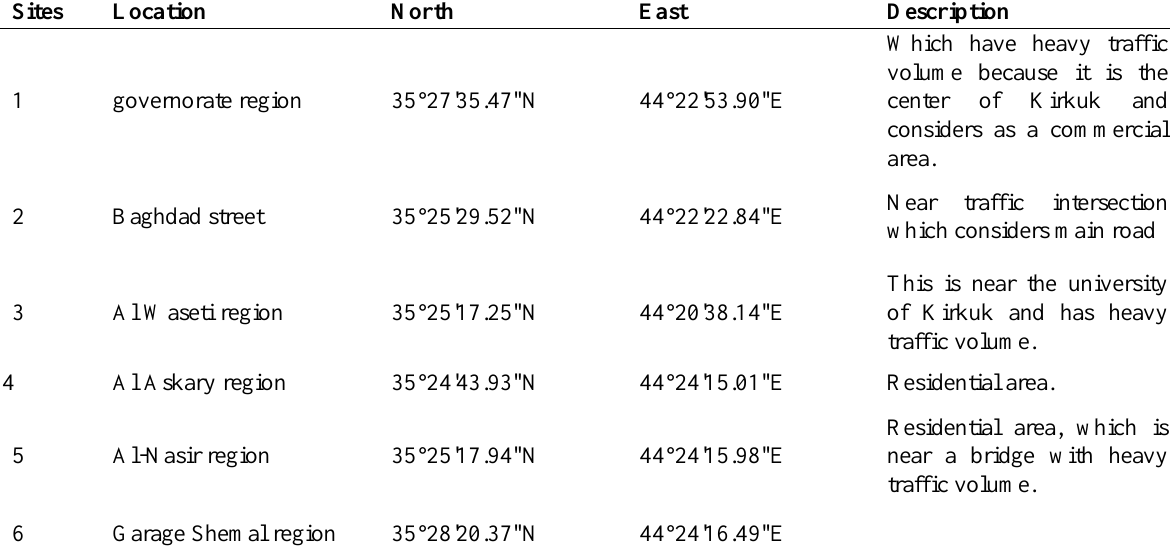
Width of median Width of Geometrical Description strip (m) road (m) Have Six paths only Three paths